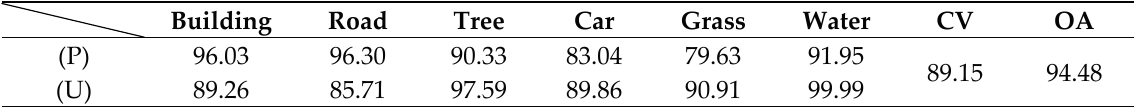
Figure 6. ( a ) The orthophoto; ( b ) DSM generated from the UAV images; ( c ) reference data; ( d ) classification with the proposed method. Table 3. Classification results of Experiment 2 (percentage (%)) (per-class producer’s (P) and user’s (U)